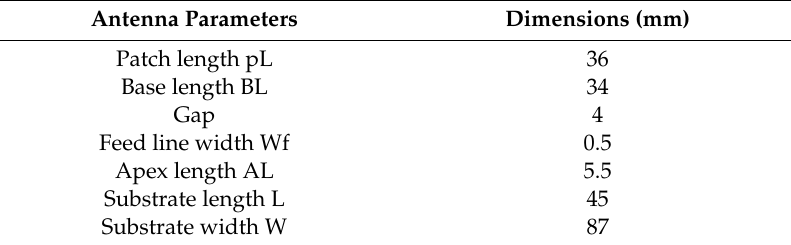
Table 4. Antenna B parameters.